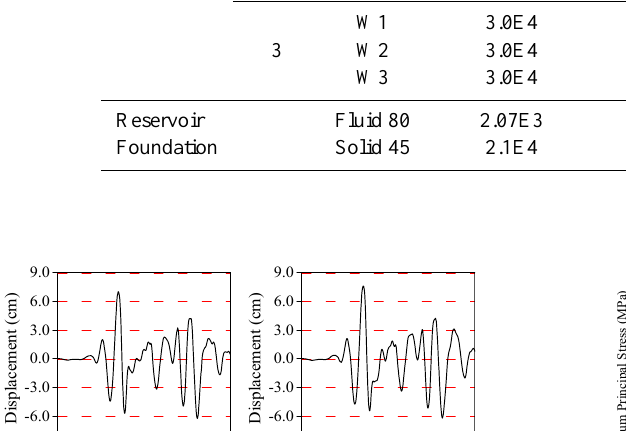
(b) Fig. 8. The maximum (a) and minimum (b) stresses at section I-I of arch dam for Case E. The time histories of maximum principal stresses (tensile stress) at nodal point 48 for each case are plotted by displaying the demand-capacity ratios (DCR) in Fig. 9 (a-c). In this study, tensile strength of concrete material is selected as 3 MPa. It is clearly seen from Fig. 9 that some values of maximum principal stresses are over than DCR=1 for all cases. It means that the maximum principal stresses occurred on the dam are much more than tensile strength of concrete used in dam body. Fig. 9. The time histories of maximum stresses at nodal point 48 of the arch dam for Case E. The performance curves at nodal point 48 (Fig. 4) of the arch dam are presented in Fig. 10 for Case E1, E2, and E3. The level of nonlinear response or opening construction joints and/or cracking of concrete is considered acceptable if the DCR value<2 (USACE, 2003). The results show that demand-capacity ratios for Case E2, and E3 are less than 2 and the cumulative inelastic durations at all demand-capacity ratios almost falls below the acceptance 12/21